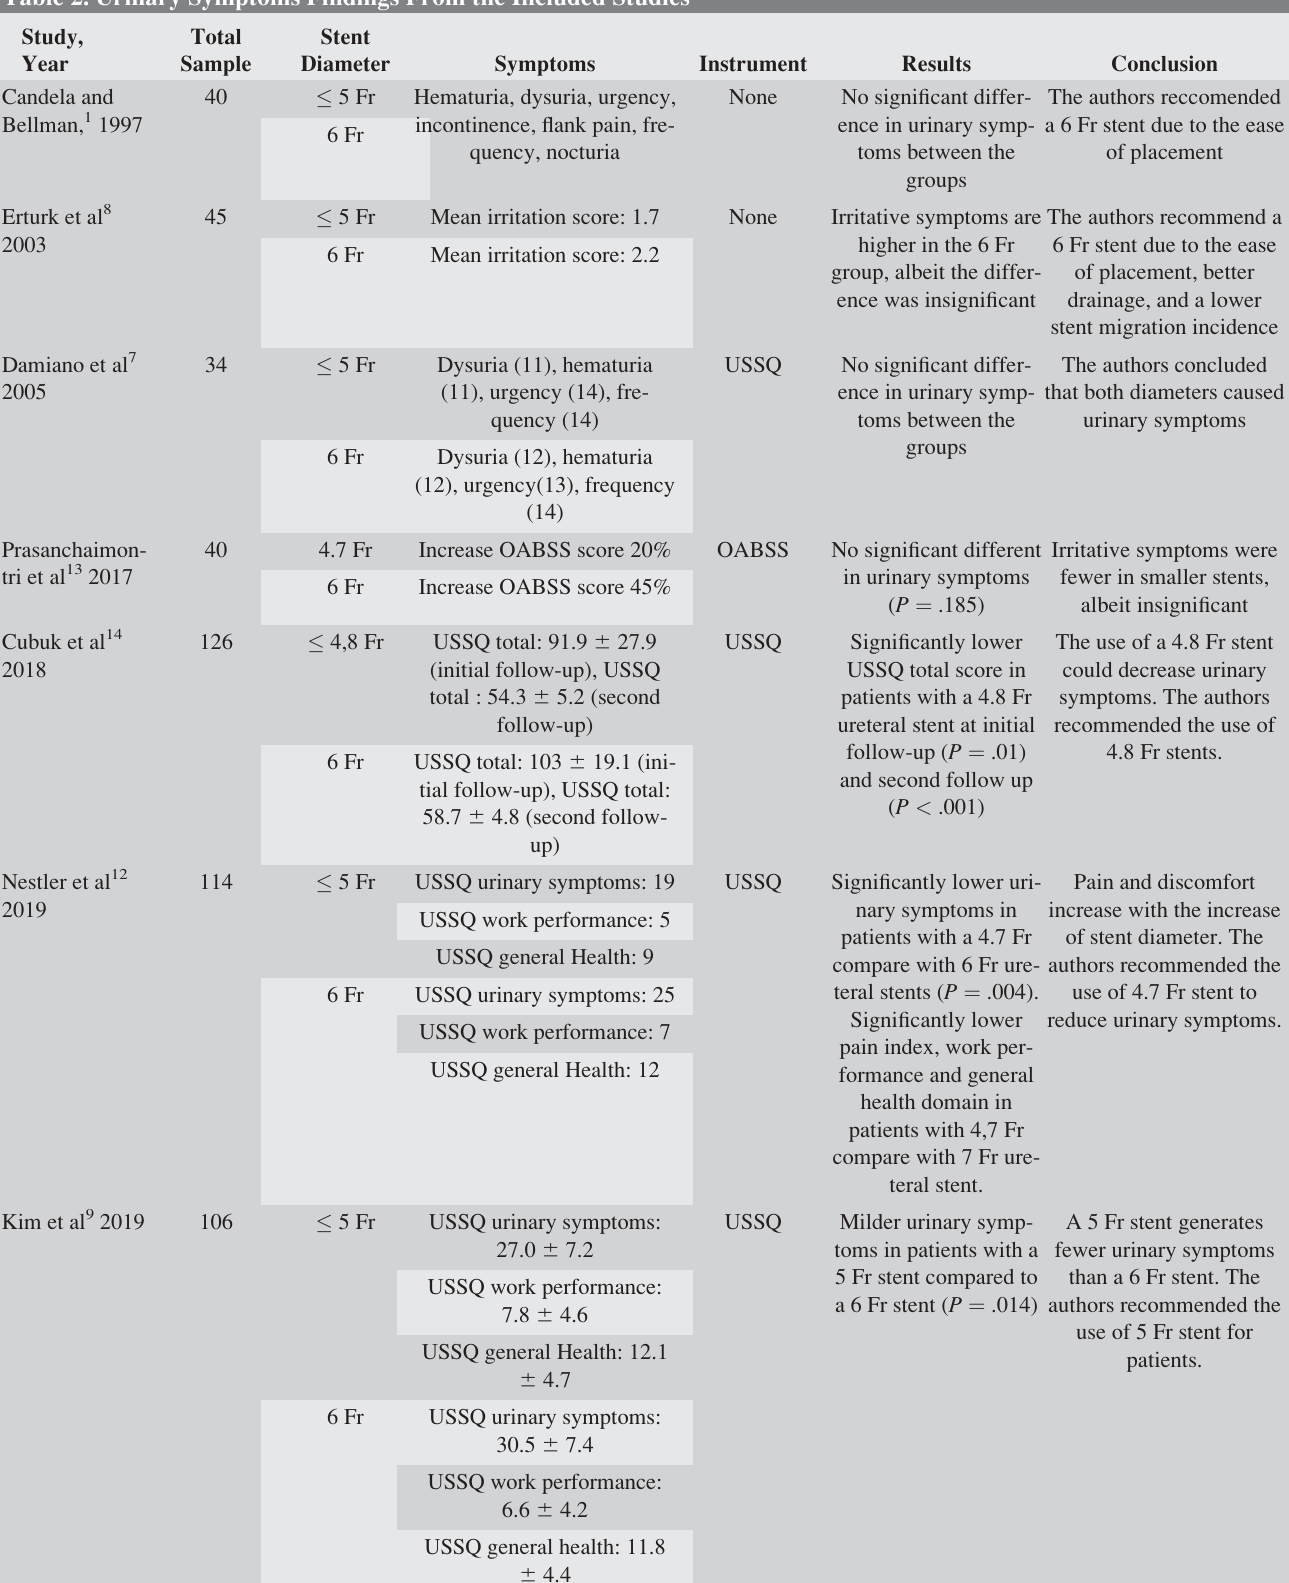
Table 2. Urinary Symptoms Findings From the Included Studies